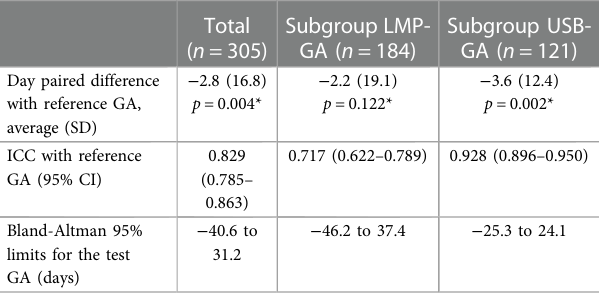
Total Subgroup LMP- Subgroup USB- ( n = 305) GA ( n = 184) GA ( n =